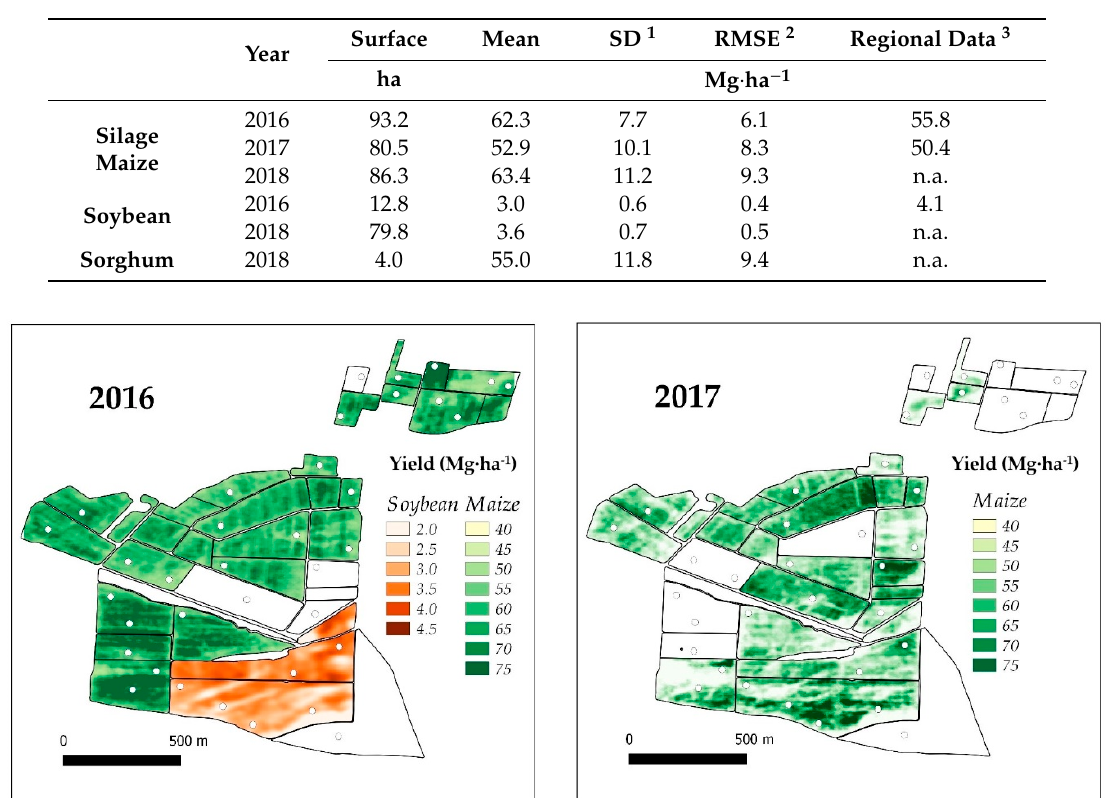
Table 2. Descriptive statistics of the yield maps. 1 : Standard deviation; 2 : Root mean square error of kriging; 3 : mean crop yield at regional scale, published by regional Directorate-General Agriculture (www.regione.lombardia.it).